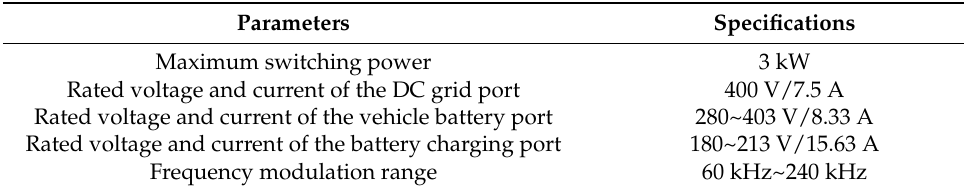
Table 4. Circuit parameters and components.